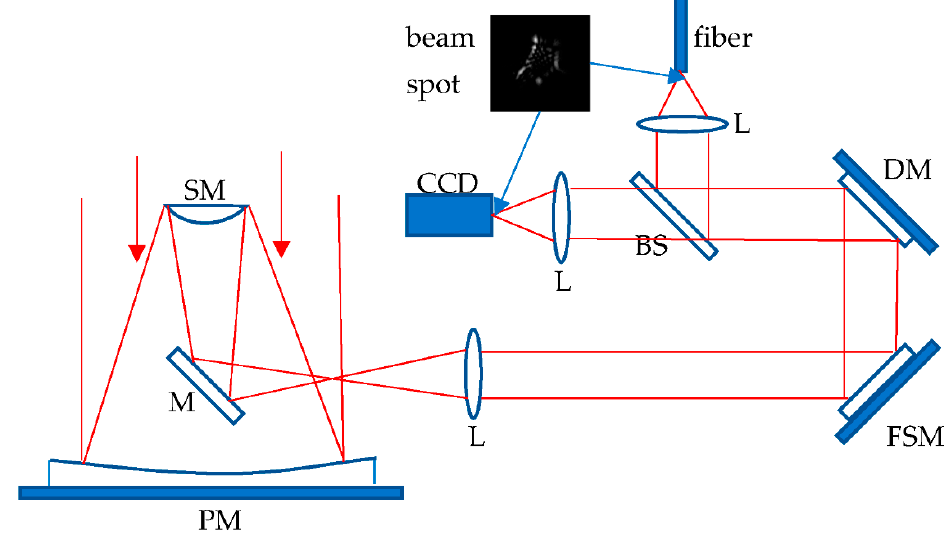
Figure 1. Schematic diagram of fiber coupling based on an image sensor in free-space optical communication. PM: primary mirror; SM: secondary mirror; M = mirror; BS = beam splitter; FSM = fast steering mirror; DM = deformable mirror; L = lens; and CCD = charge-coupled device.